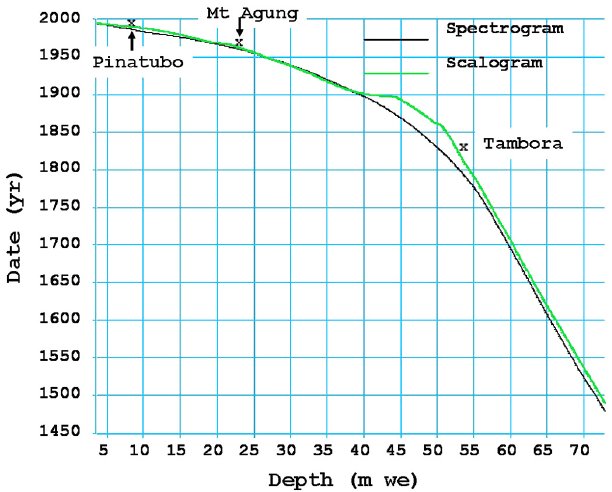
Figure 9. Illimani chronologies deduced from the NO 3 concentra- tion depth profile and using the spectrogram (black line) and the scalogram (green